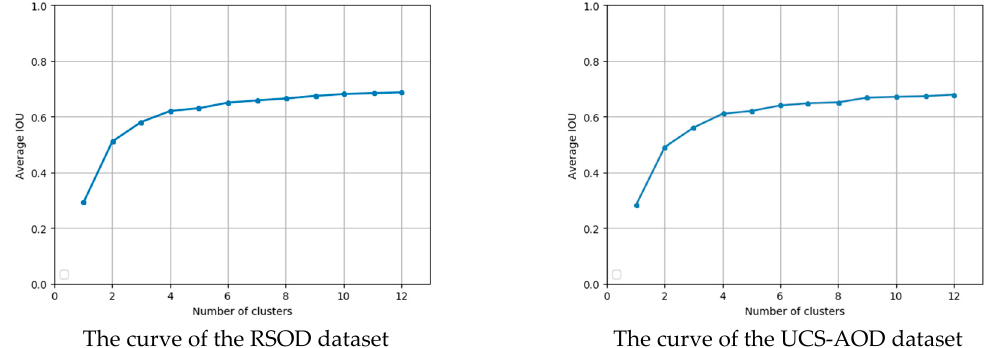
The curve of the RSOD dataset The curve of the UCS-AOD dataset